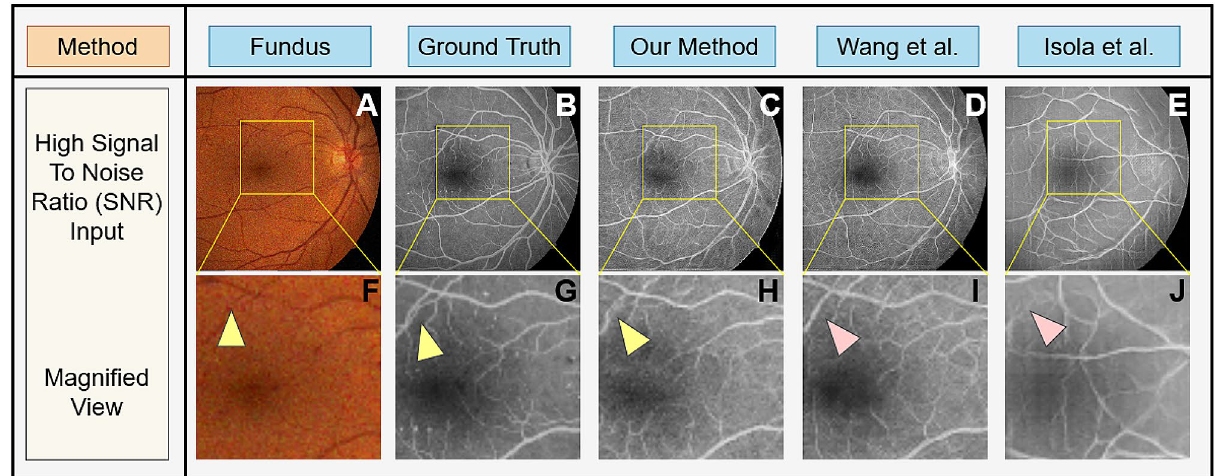
Figure 6. Paired fundus photographs ( A ) acquired under high signal to noise ration (SNR) and ground truth FA images ( B ). FA images generated by our proposed method ( C) and those generated by traditional GANs proposed by Wang et al. ( D ) 50 and Isola et al. ( E ) 27 . Subfigures ( F–J ) show magnification of the yellow boxed areas from ( A–E ). Microvascular structures are not quite visible in the fundus photographs ( A,F ), but are visible in the original FA images ( B,G ) pointed to by the yellow triangles. Our deep learning GAN is capable of producing these microvascular structures pointed to by the yellow triangle, as well as macro vasular structures ( C,H ). The GAN proposed by Wang et al. 50 misses these microvascular structures ( D,I ) while GAN proposed by Isola et al. 27 is not able to produce any reliable vascular structure ( E,J )—see red triangles.